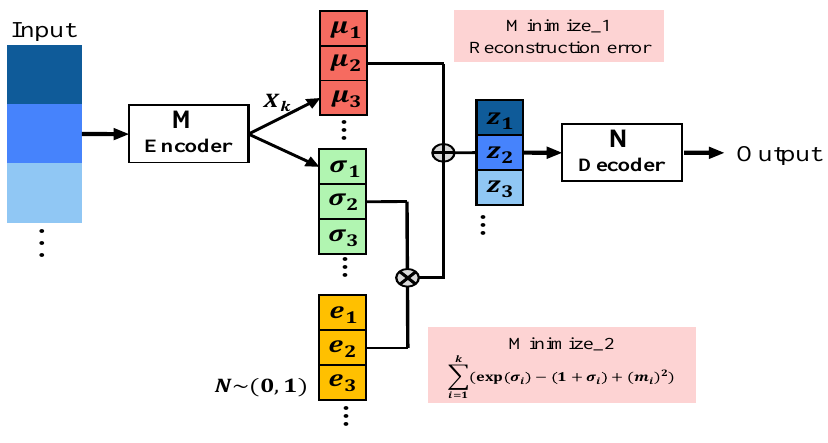
Figure 2. The architecture of